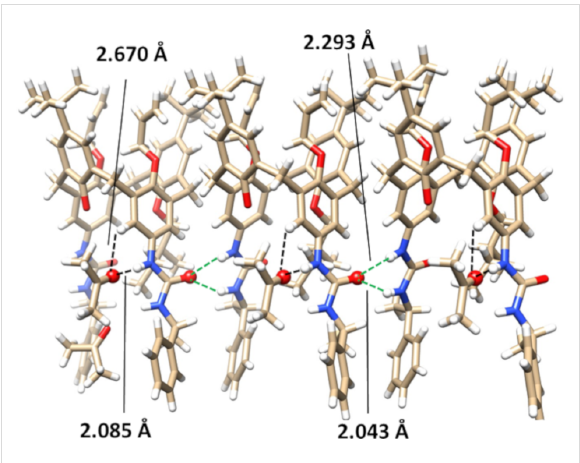
Figure 4: X-ray structure of 7d , showing hydrogen bonds between the ureido units (green) and hydrogen bonding of acetone molecules (black). One alkyl group in each calixarene was removed for better clarity.